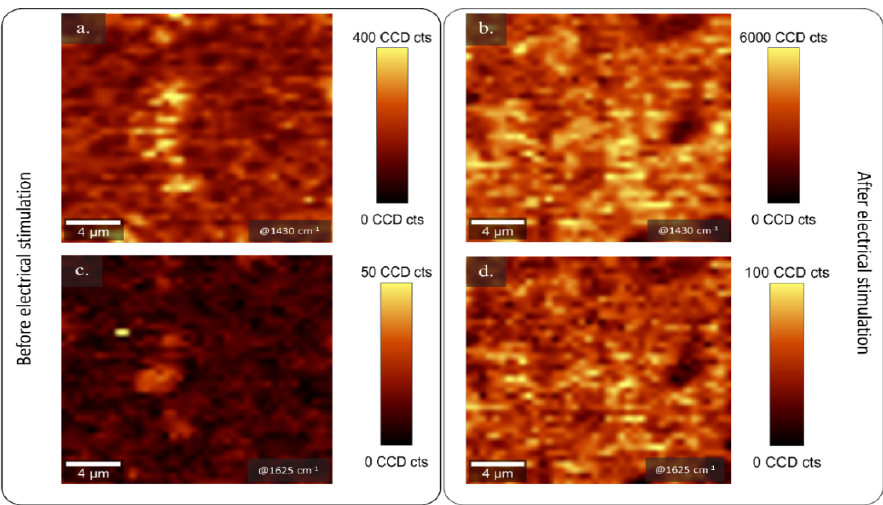
Figure 3. 2D confocal Raman map of the 1430 cm − 1 band ( a ) before release process and ( b ) after 160 release cycles. Raman mapping of the 1625 cm − 1 band intensity ( c ) before release process and ( d ) after 160 release cycles at 0.5 µ m depth inside the conductive layer. The yellow areas are related to the presence of PEDOT and κ C/Dx, respectively.